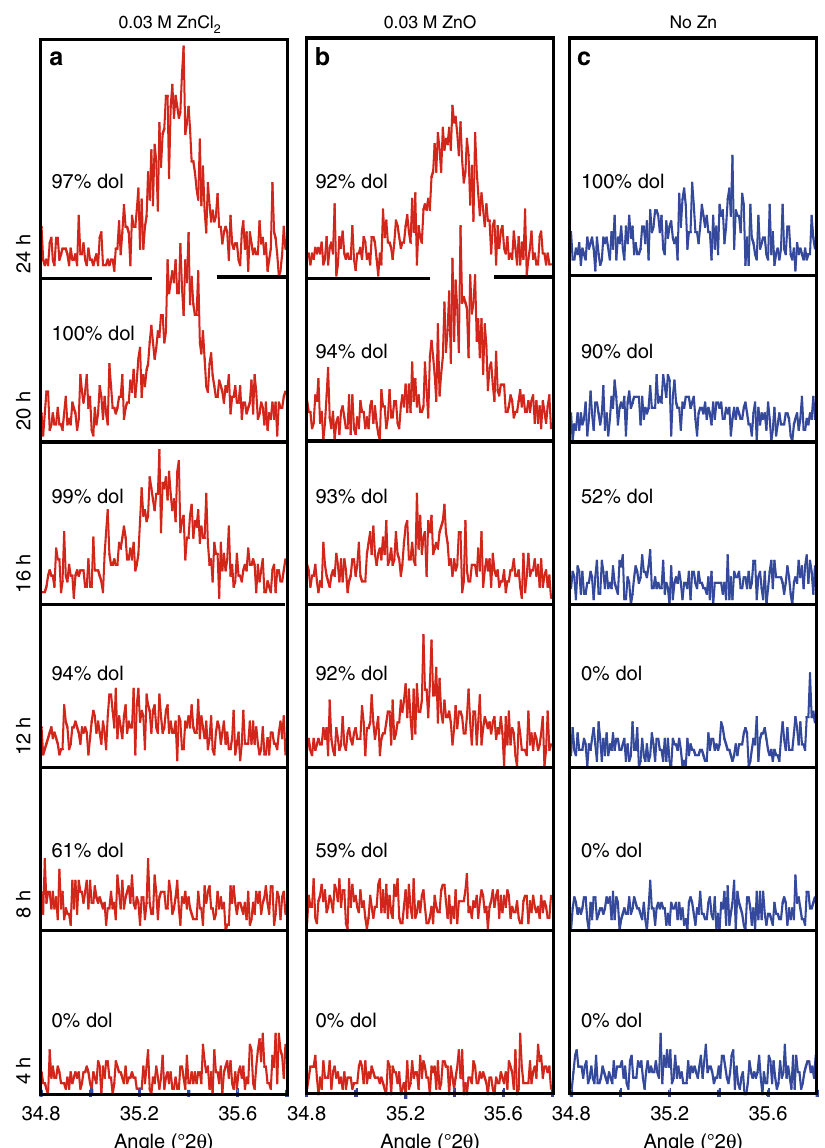
Fig. 2 Powder X-ray diffractogram selected area (34.8-35.8 °2 θ ) of reaction products. The crystallographic data of the reaction products in the 0.03 M ZnCl 2 experiments ( a ), the 0.03 M ZnO experiments ( b ), and the Zn-free control series ( c ) show that only reaction products with more than 90% dolomite contain well-ordered dolomite, giving an indication of the protodolomite to dolomite recrystallization rate. The % dol refers to the percentage of (proto)dolomite as calculated from the main (104) dolomite